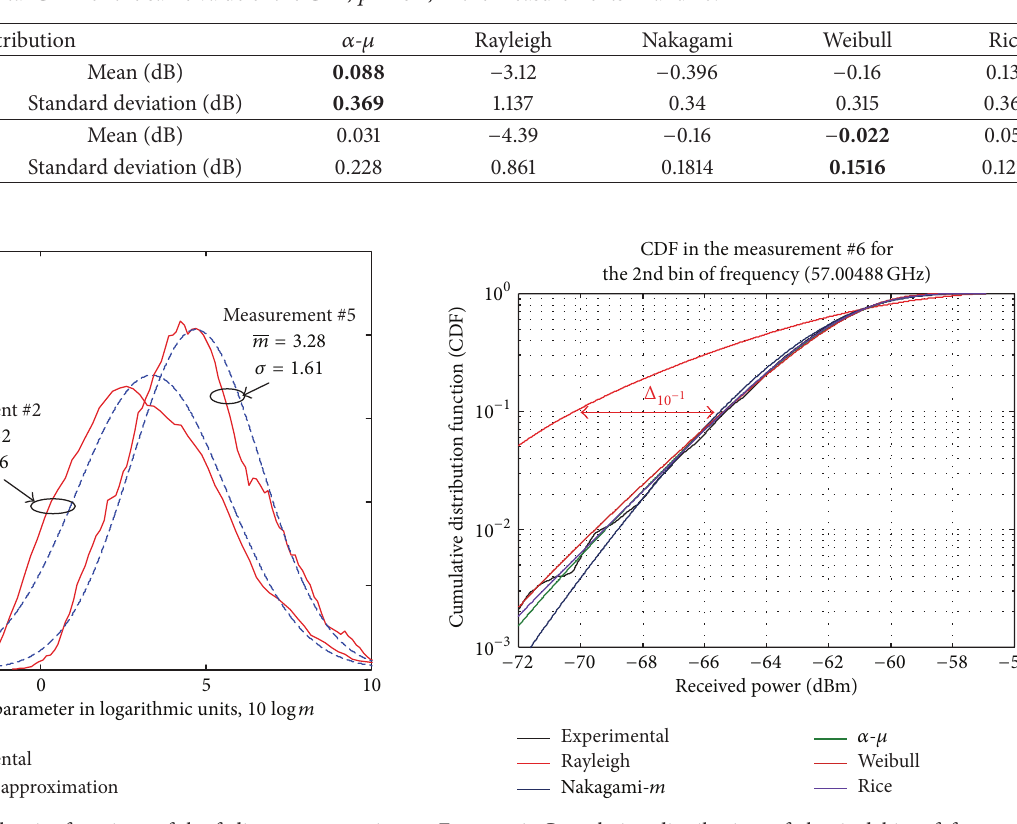
Figure 6: Cumulative distribution of the 2nd bin of frequency (57.00488 GHz) in the measurement #6. The difference between the relative received power of the estimated CDF and the relative received power of the experimental CDF for the same value of the CDF, 𝑝 = 10 −1 , is shown for the Rayleigh